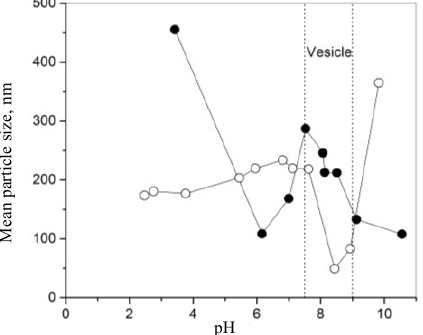
Figure 3. Mean zeta potential of 12.5 mM linolenic acid (●) and 12.5 mM PEGylated linolenic acid (○) at various pH.